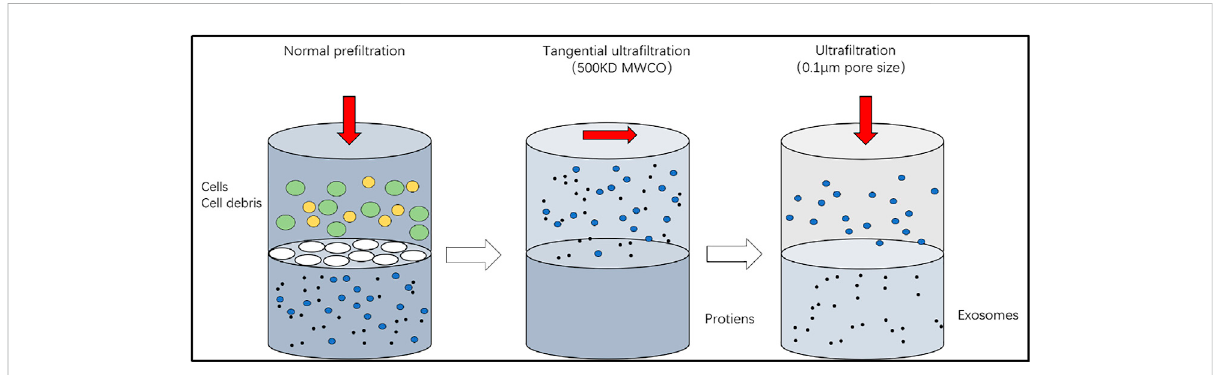
Ultra fi ltration. The principle is based on the size of the exosomes, and the sample is separated using a special aperture fi lter, which removes molecules such as proteins, while retaining the